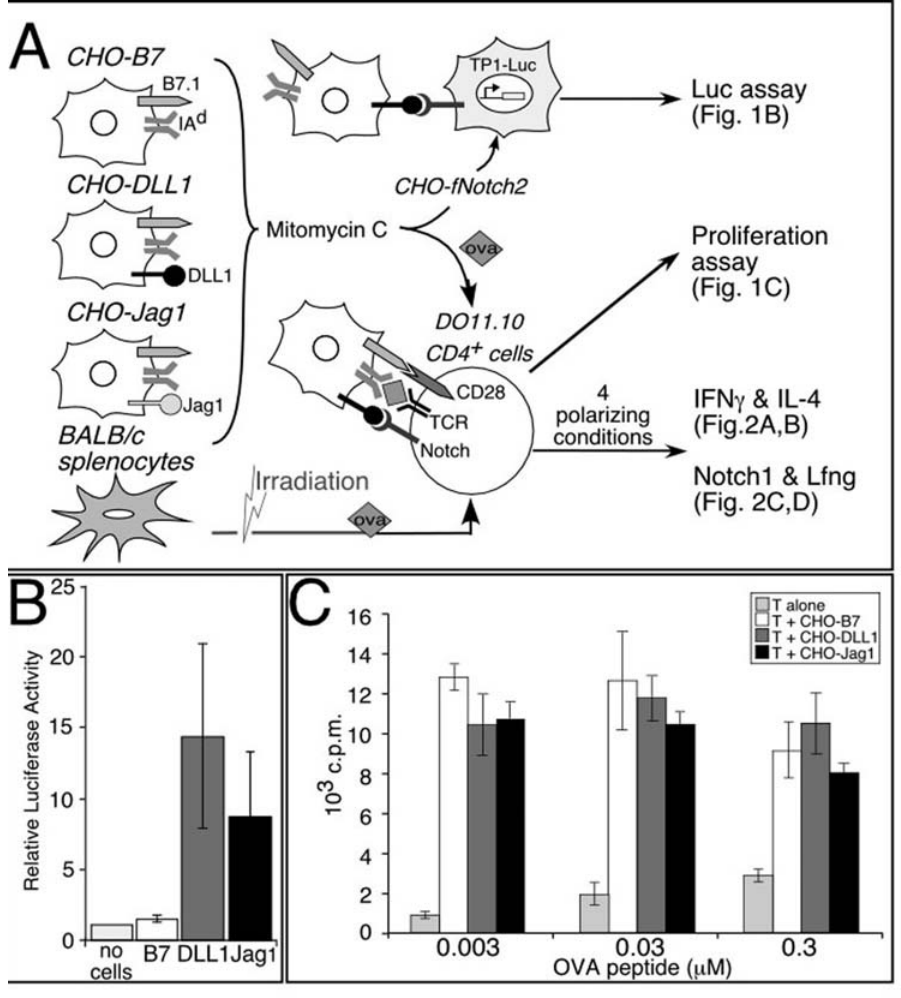
Figure 1. Functional Notch ligands on APCs do not affect APC-mediated T cell proliferation. (A) Schematic of the experiment. Artificial APC lines were treated with mitomycin C (100 m g/ml for 1 h) and seeded either for co-culture reporter assay or for activating naı¨ve CD4 + T cells isolated from DO11.10 mice. Irradiated BALB/c spleen cells were used as the natural APC control. Activated CD4 + T cells were assayed for the rate of proliferation, level of IFN c and IL-4 production under the 4 polarizing conditions, and the presence of activated Notch1 and Lfng proteins. (B) The Notch ligands expressed on APC lines elicit Notch2 cleavage and RBP-J-dependent transcriptional activation of TP1 -luciferase in co-culture system. Results are mean 6 S.D. of three independent experiments. (C) Functional Notch ligands on APC lines do not affect T cell proliferation. Naı¨ve CD4 + T cells purified from DO11.10 mice were cultured with the different APC lines under various concentrations of OVA peptide, as indicated on the horizontal axis. The cultures were pulsed with [ 3 H] thymidine at 48 h, harvested and analyzed at 60 h. Data represent c.p.m 6 s.d. from triplicate